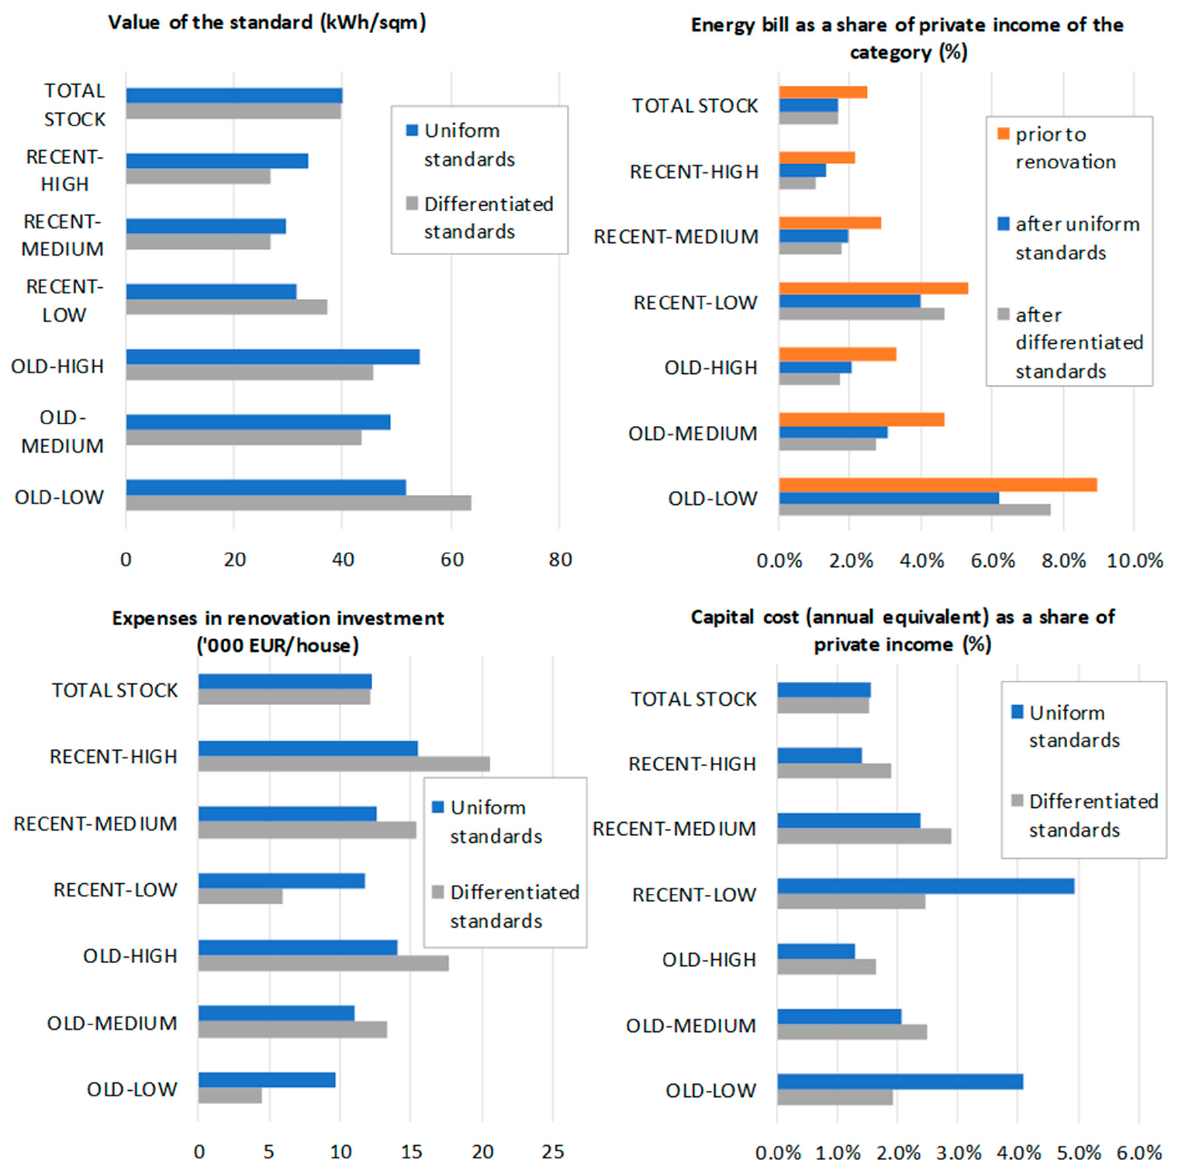
Figure 6. Model results for the standards’ policy case.